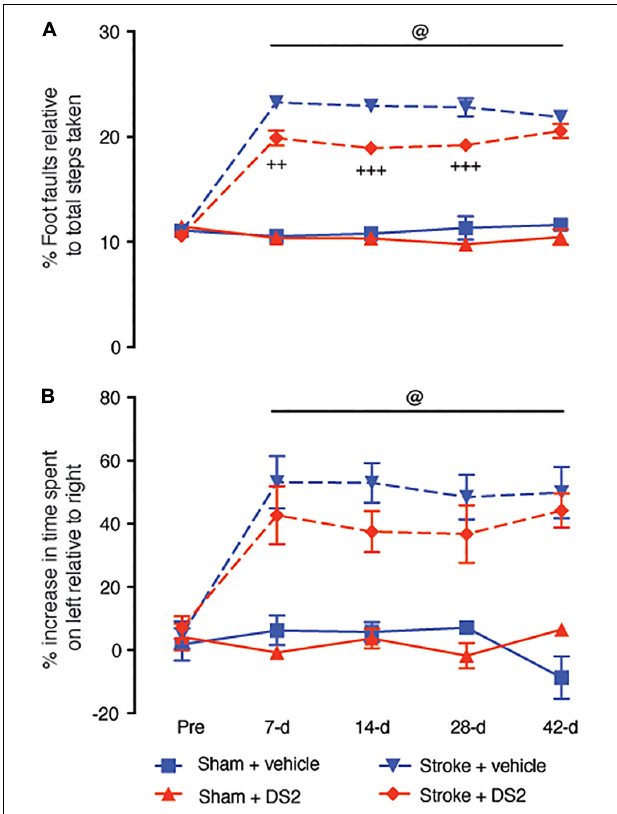
FIGURE 4 | Delayed administration of DS2 from day-3 post-stroke improves functional outcomes when continuously administered. Mice were subjected to focal stroke or sham surgery and DS2 (10 mM, red) or vehicle (blue) were loaded into ALZET 1002 mini-pumps and implanted subcutaneously from 3-days post-stroke. Mini-pumps were replaced after 2 week with new pumps to allow for continuous treatment for 28-days after stroke. Mice were assessed for functional deficits using the (A) grid-walking (foot-faults) and (B) cylinder task (forelimb asymmetry). Data are expressed as mean ± SD for n = 7 per group. +++ P < 0.001, ++ P < 0.01 compared to stroke vehicle control. @ P < 0.001 compared to sham